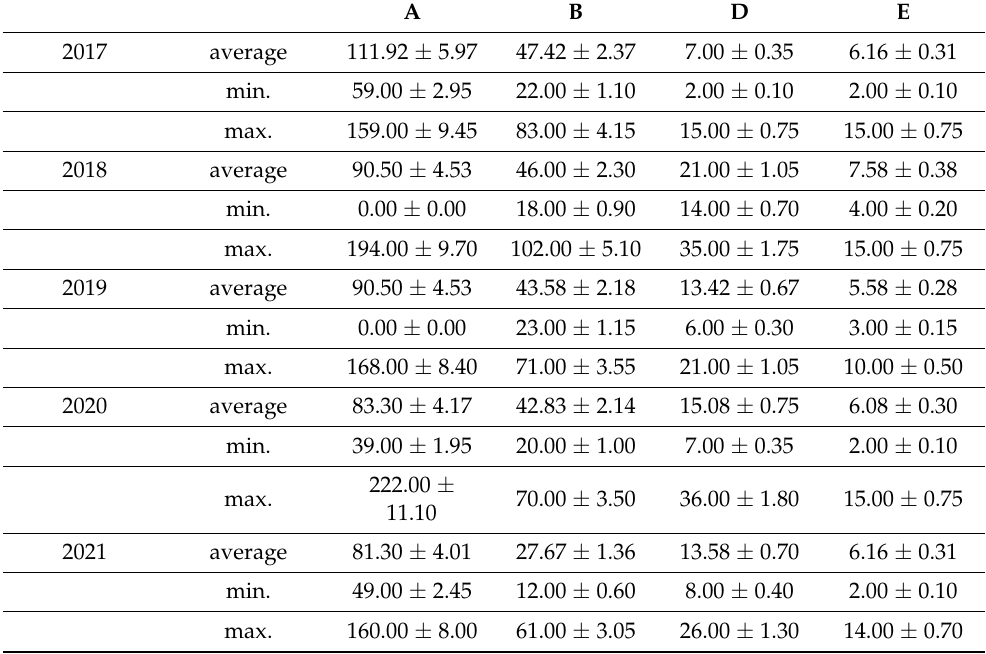
Figure 7. Average annual NO X concentrations at locations A, B, D, and E between 2017 and 2021. Table 2. Average, minimum, and maximum annual NO X ( µ g/m 3 ) values at studied locations.